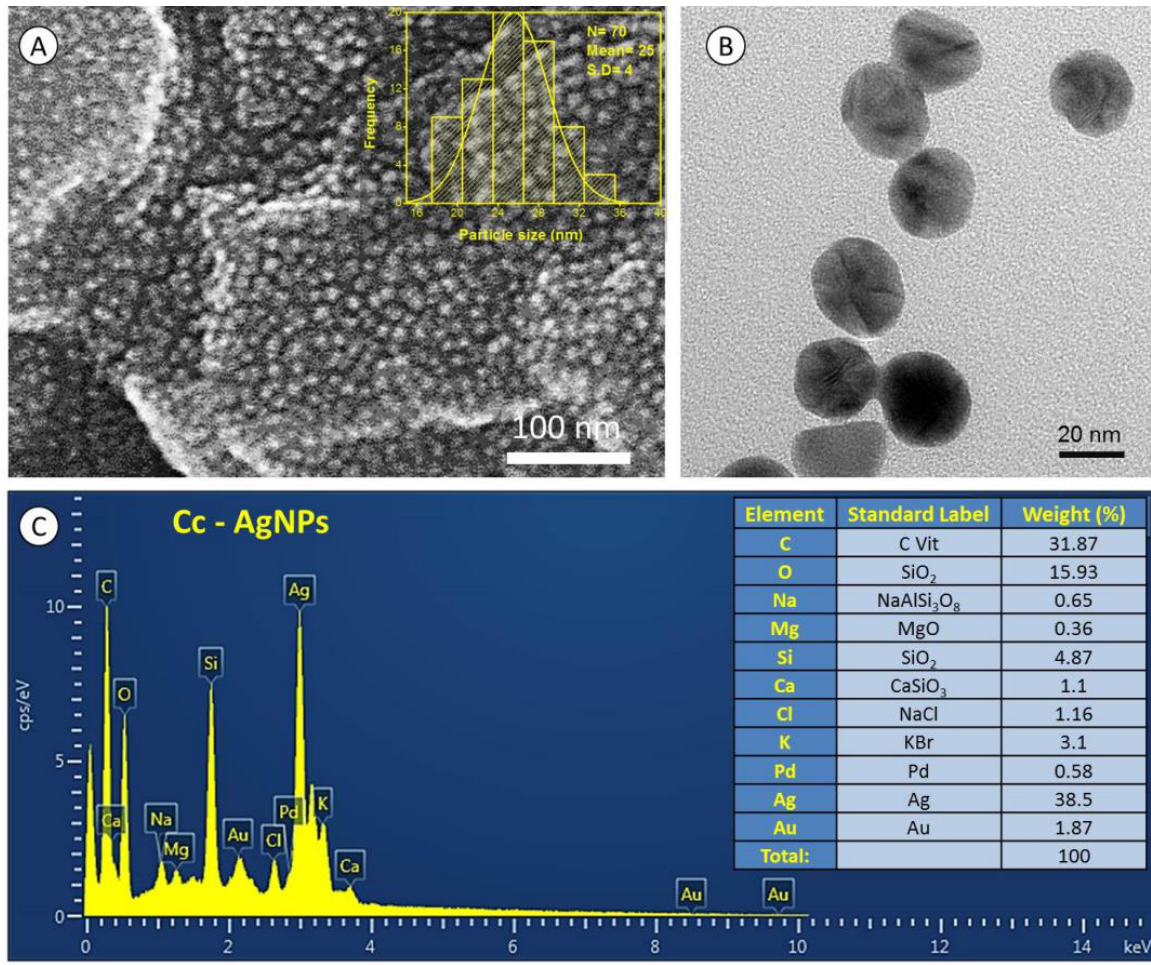
Figure 3. ( A ) SEM micrograph shows a relatively spherical shape of C. colocynthis silver nanoparti- cles (Cc-AgNPs), and the inset represents size distribution histogram. ( B ) TEM image reveals the morphology of individual nanoparticles. ( C ) EDX spectrum of Cc-AgNPs shows strong signal of silver (Ag), and the inset table presents % weight of each element.